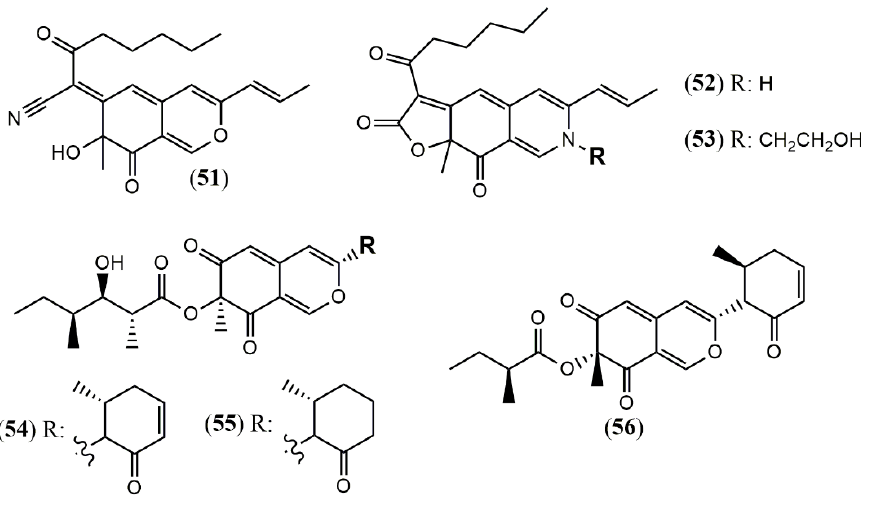
Figure 5. Chemical structures of Monascus and Muyocopron azaphilones: 51 : monapilonitrile; 52 : monapilosine; 53 : N-ethanolic monapilosine; and Muyocopron azaphilones: 54–55 : muyocoprones A and B; 56 : lijiquinone 1 [50,51].